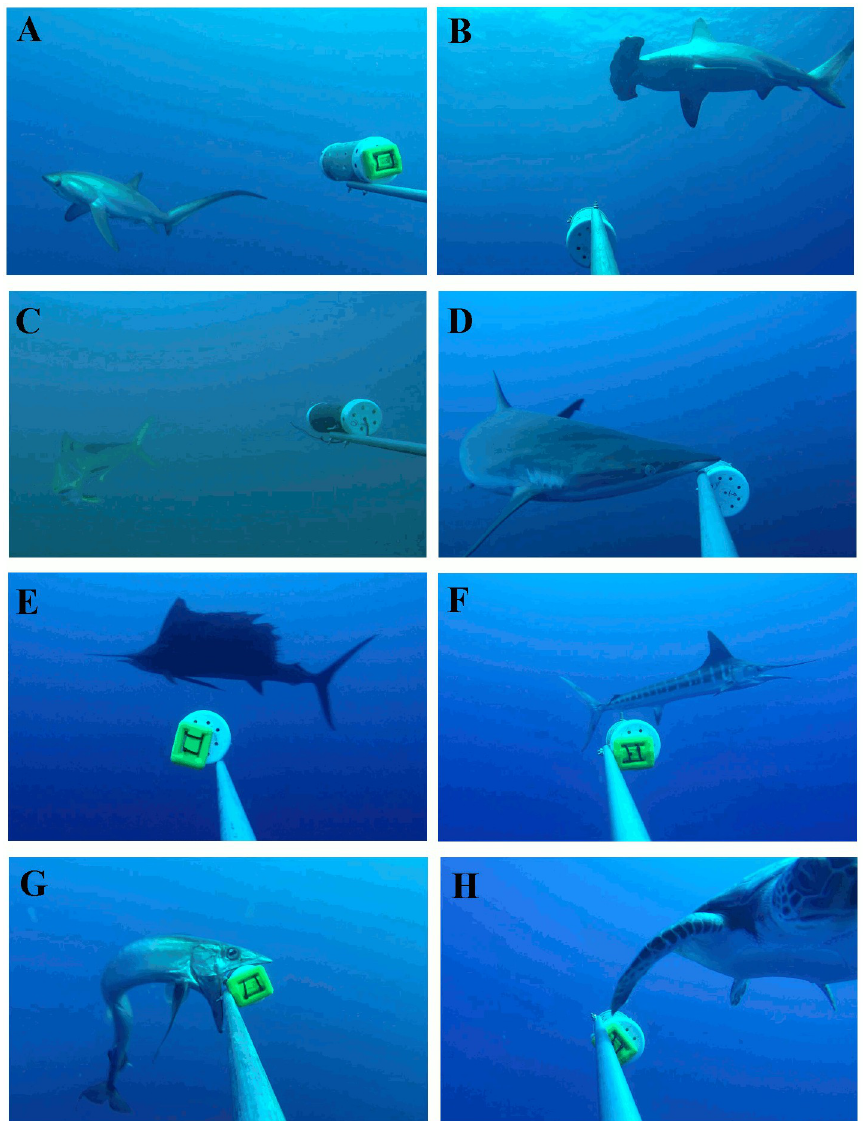
Fig 3. Images of large pelagic species detected by baited remote underwater video stations (BRUVS). A) Thresher shark (Alopias pelagicus) . B) Hammerhead shark (Sphyrna lewini) . C) Mahi-mahi (Coryphaena hippurus) . D) Silky shark (Carcharhinus falciformis) . E) Sail fish (Istiophorus platypterus) . F) Stripped marlin (Kajikia audax) . G) Lancet fish (Alepisaurus ferox) . D) Pacific black sea turtle (Chelonia mydas) .